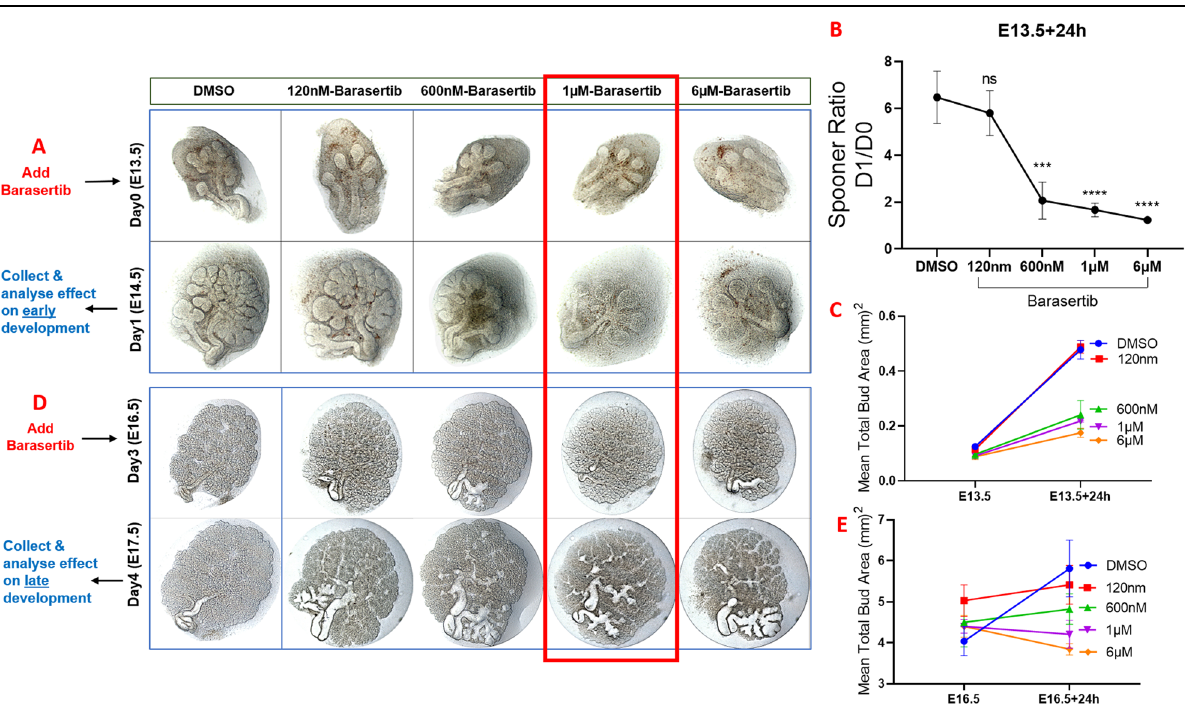
Fig. 2 Inhibition of AURKB activity during early and late development of the embryonic submandibular glands. Inhibition of AURKB using Barasertib in the early ( A – C ) and late E-SMGs ( D , E ). Treatment of the explants with Barasertib for 24h reduced Spooner ratio in the early explants ( B ) and inhibited expansion of SMG buds in a dose-dependent manner ( C , E ). Analysis demonstrated gradual reduction of the mean total bud area with increasing doses of Barasertib, which was more clearly seen in the mature explants (late development) ( D , E ), n = 3 for each group. All downstream experiments were conducted using Barasertib at 1 µM (red